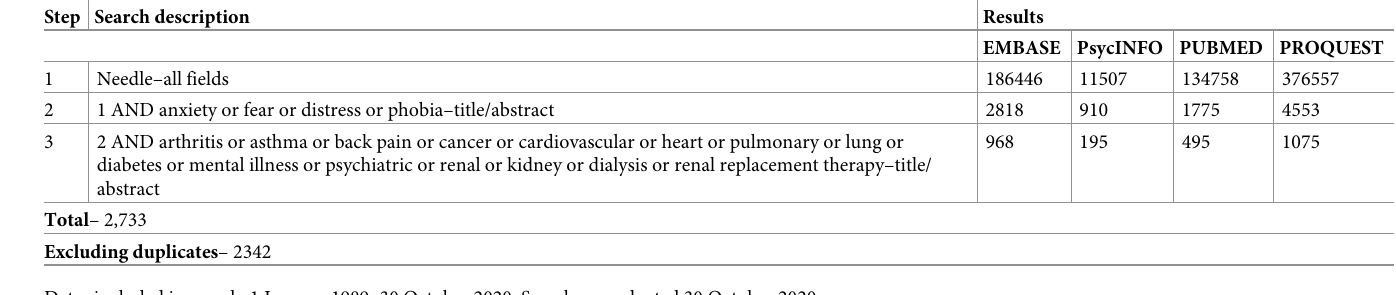
Table 1. Search strategy, terms and results for traditional